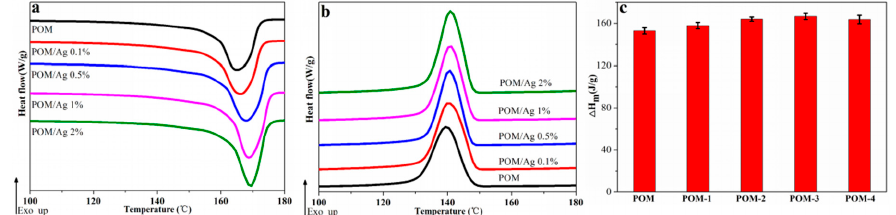
Figure 3. ( a ) Second melting endotherms, ( b ) crystallization exotherms and ( c ) the enthalpy values of